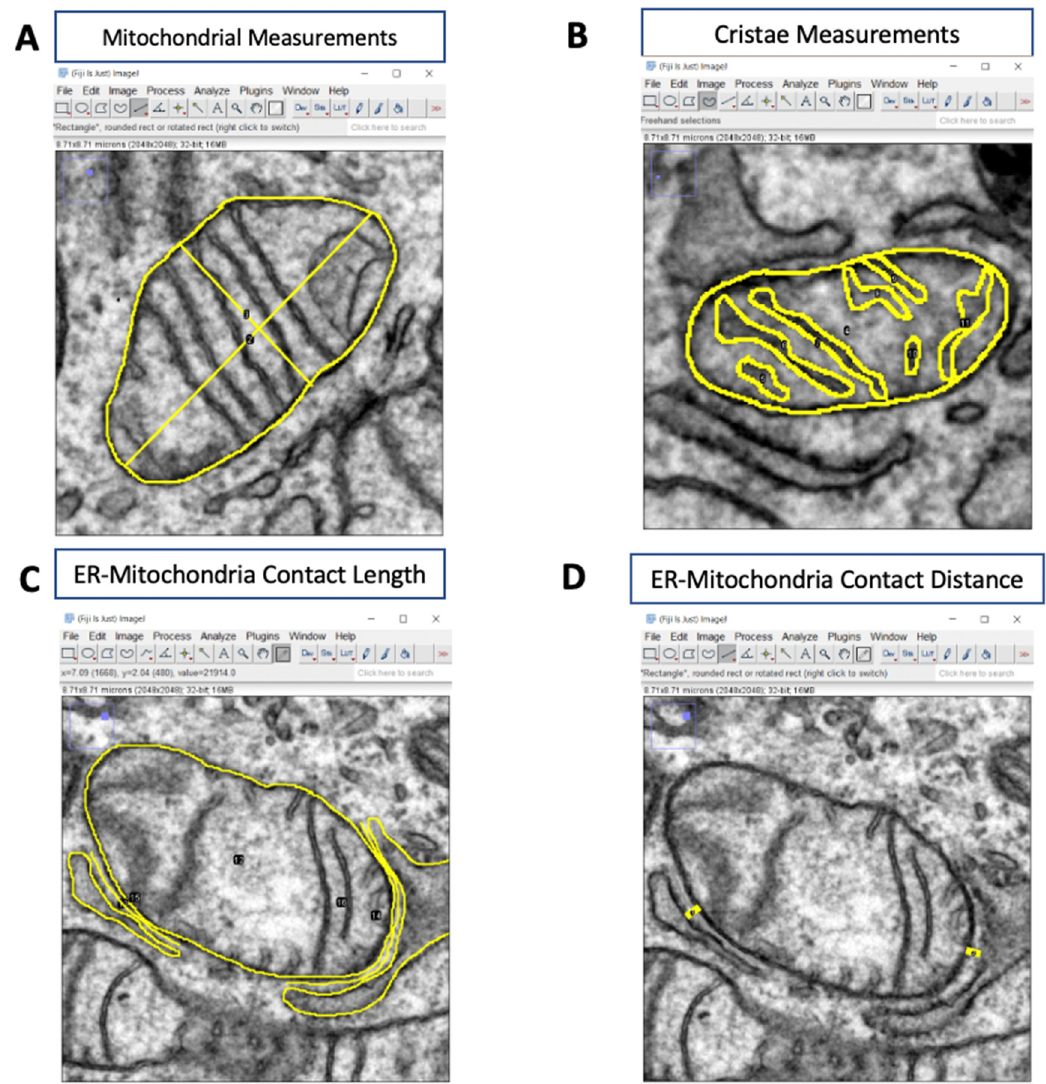
Figure 2. Analyzing organelle morphology with ImageJ . ( A ) Representative TEM image illustrating how to measure mitochondrial length, width, area, and circularity. ( B ) Representative TEM image illustrating how to obtain cristae measurements (yellow). ( C , D ) Representative TEM images illustrating how to determine ER-mitochondria contact length and ER-mitochondria contact distance (yellow).